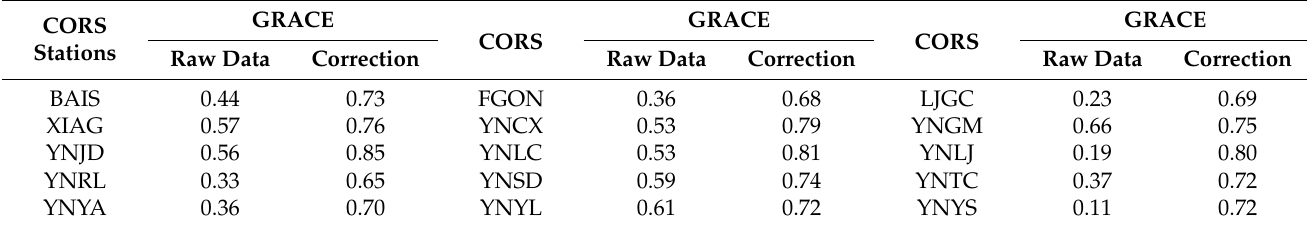
Table 7. Correlation coefficients between CORS and GRACE inverse results.